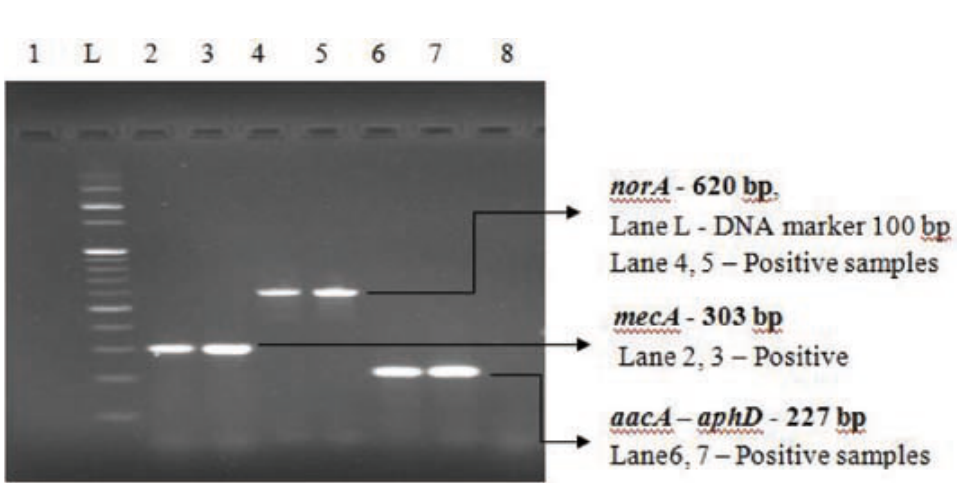
Fig. 3 .PCR for detection of CNS